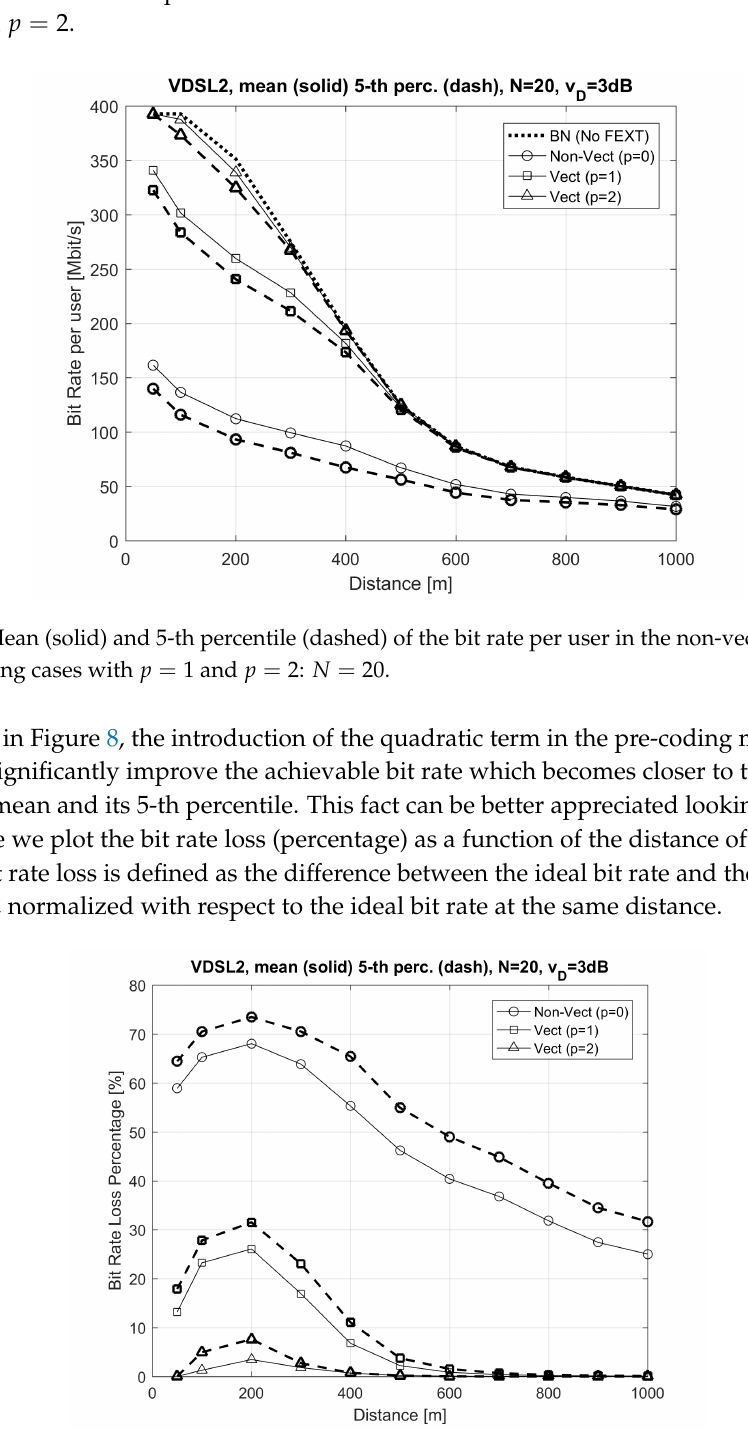
Figure 9. Bit rate loss percentage as a function of the distance. Non-vectoring ( p = 0), and vectoring cases, with p = 1 and p = 2, are